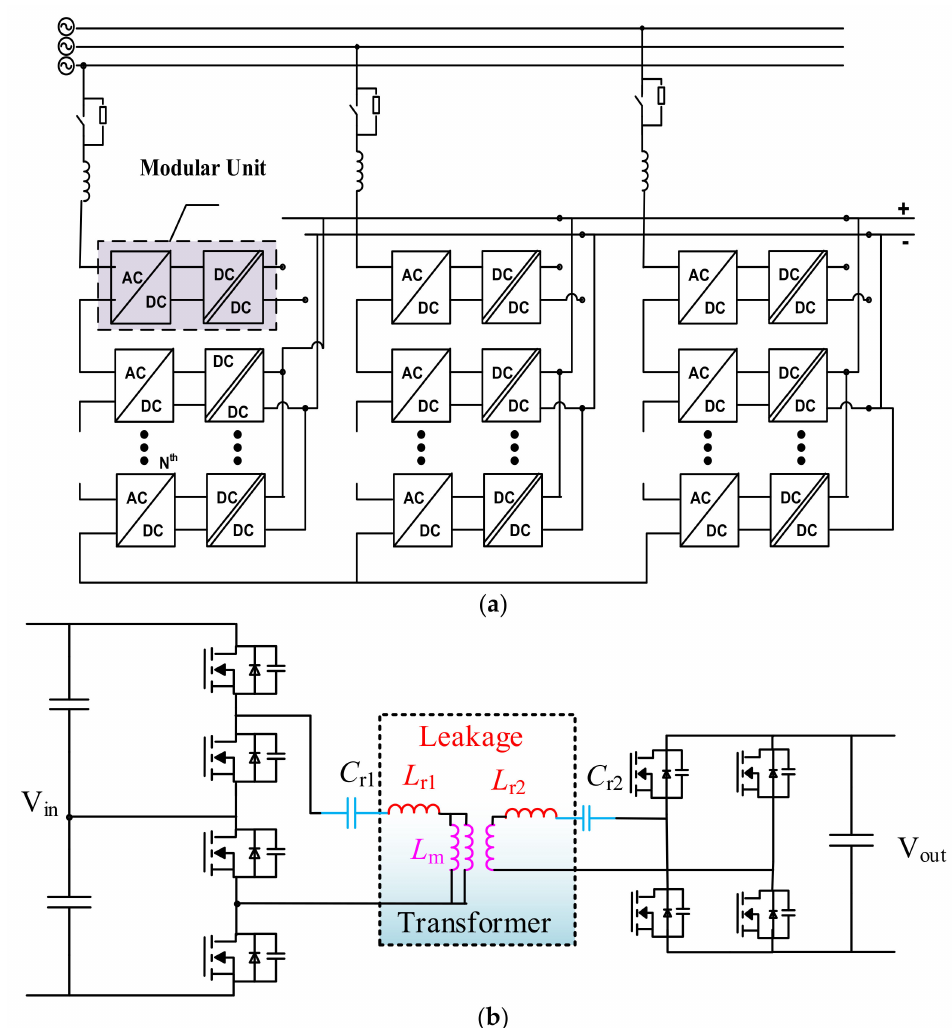
Figure 1. ( a ) Configuration of power electronic transformer. ( b ) DC–DC converter